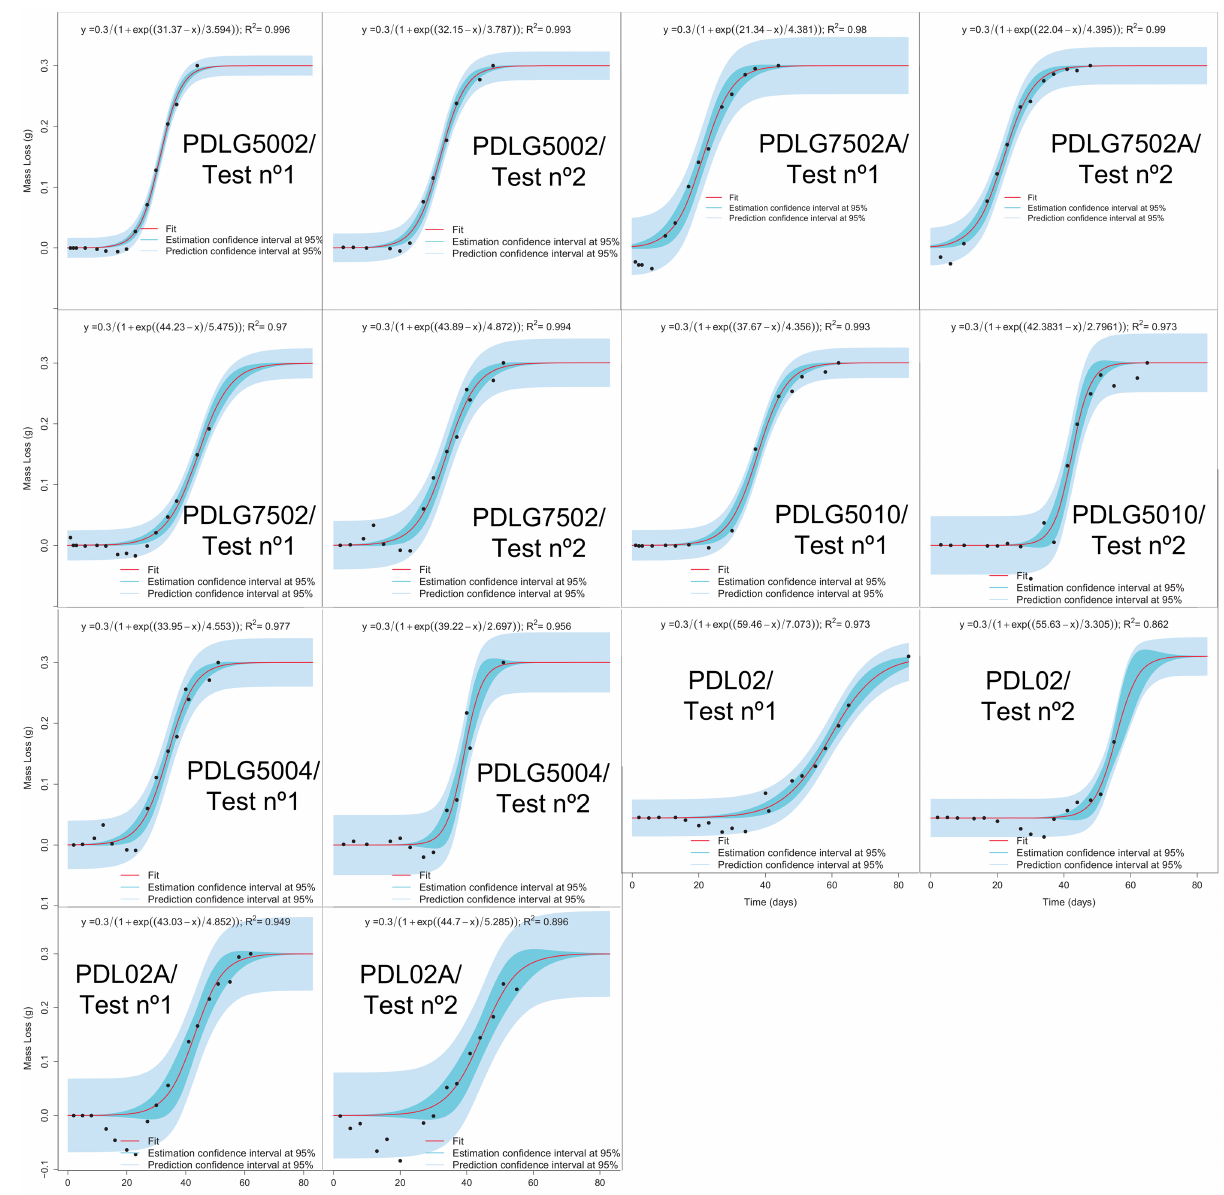
Fig 10. The fittings of fixed effects nonlinear regression models based on logistic function are shown. Each panel corresponds with the fitting of each degradation path. The expression of the model (with parameter estimates), goodness of fit measurements (R 2 ) and both prediction and estimation intervals are also